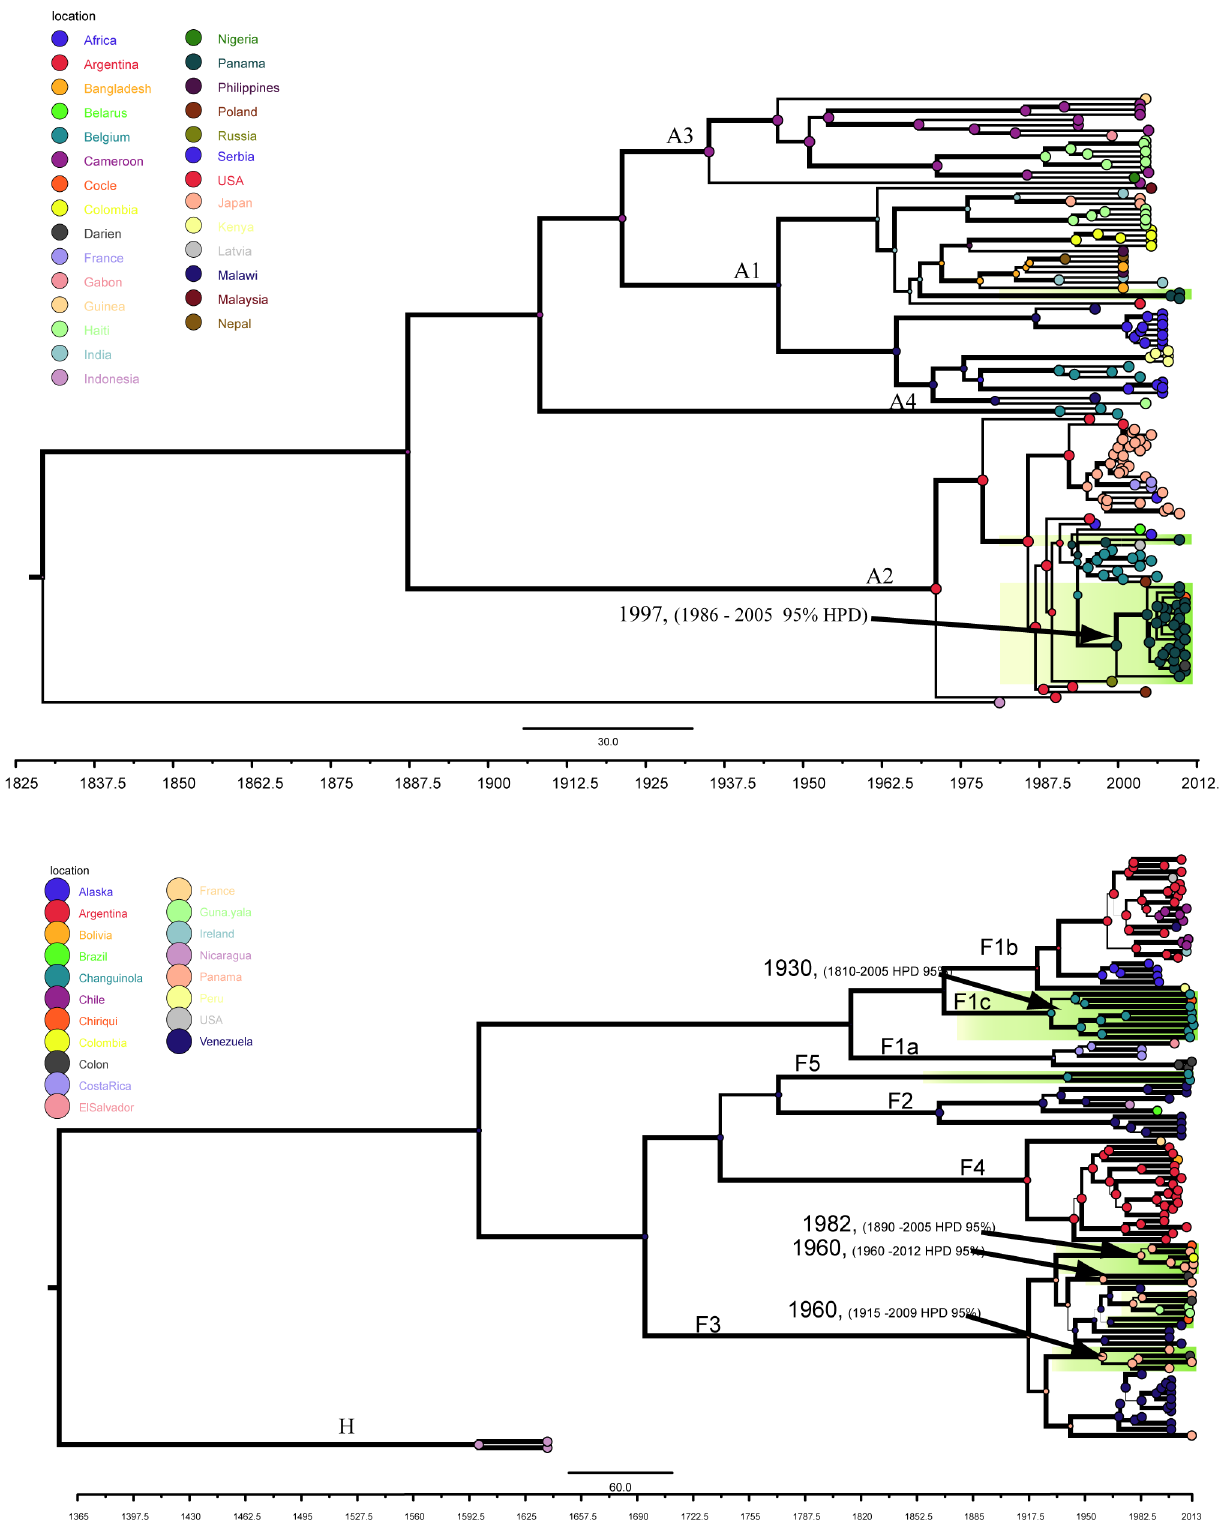
Fig 3. MCC trees showing the time resolved phylogenies of the Panamanian samples. The tree was draw using the whole genome sequences of the Panamanian samples and sequences published elsewhere for genotypes A (a) and F (b). The date of MRCA is shown in the node of relevant sub-genotypes